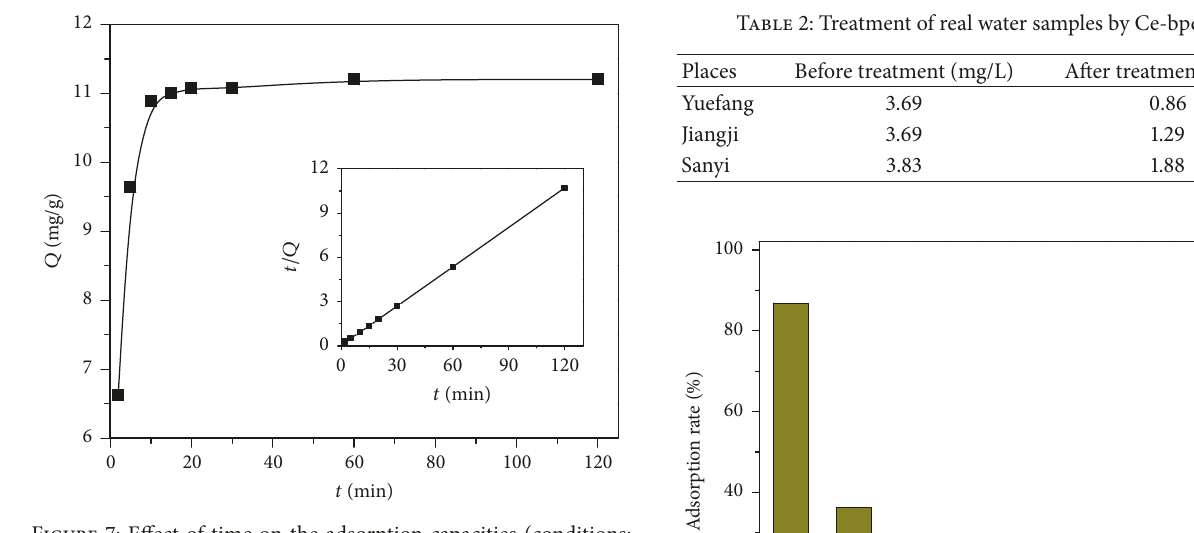
Figure 7: Effect of time on the adsorption capacities (conditions: initial concentration of solution, 12mg/L; amount of adsorbent, 1.0g/L; pH = 6).